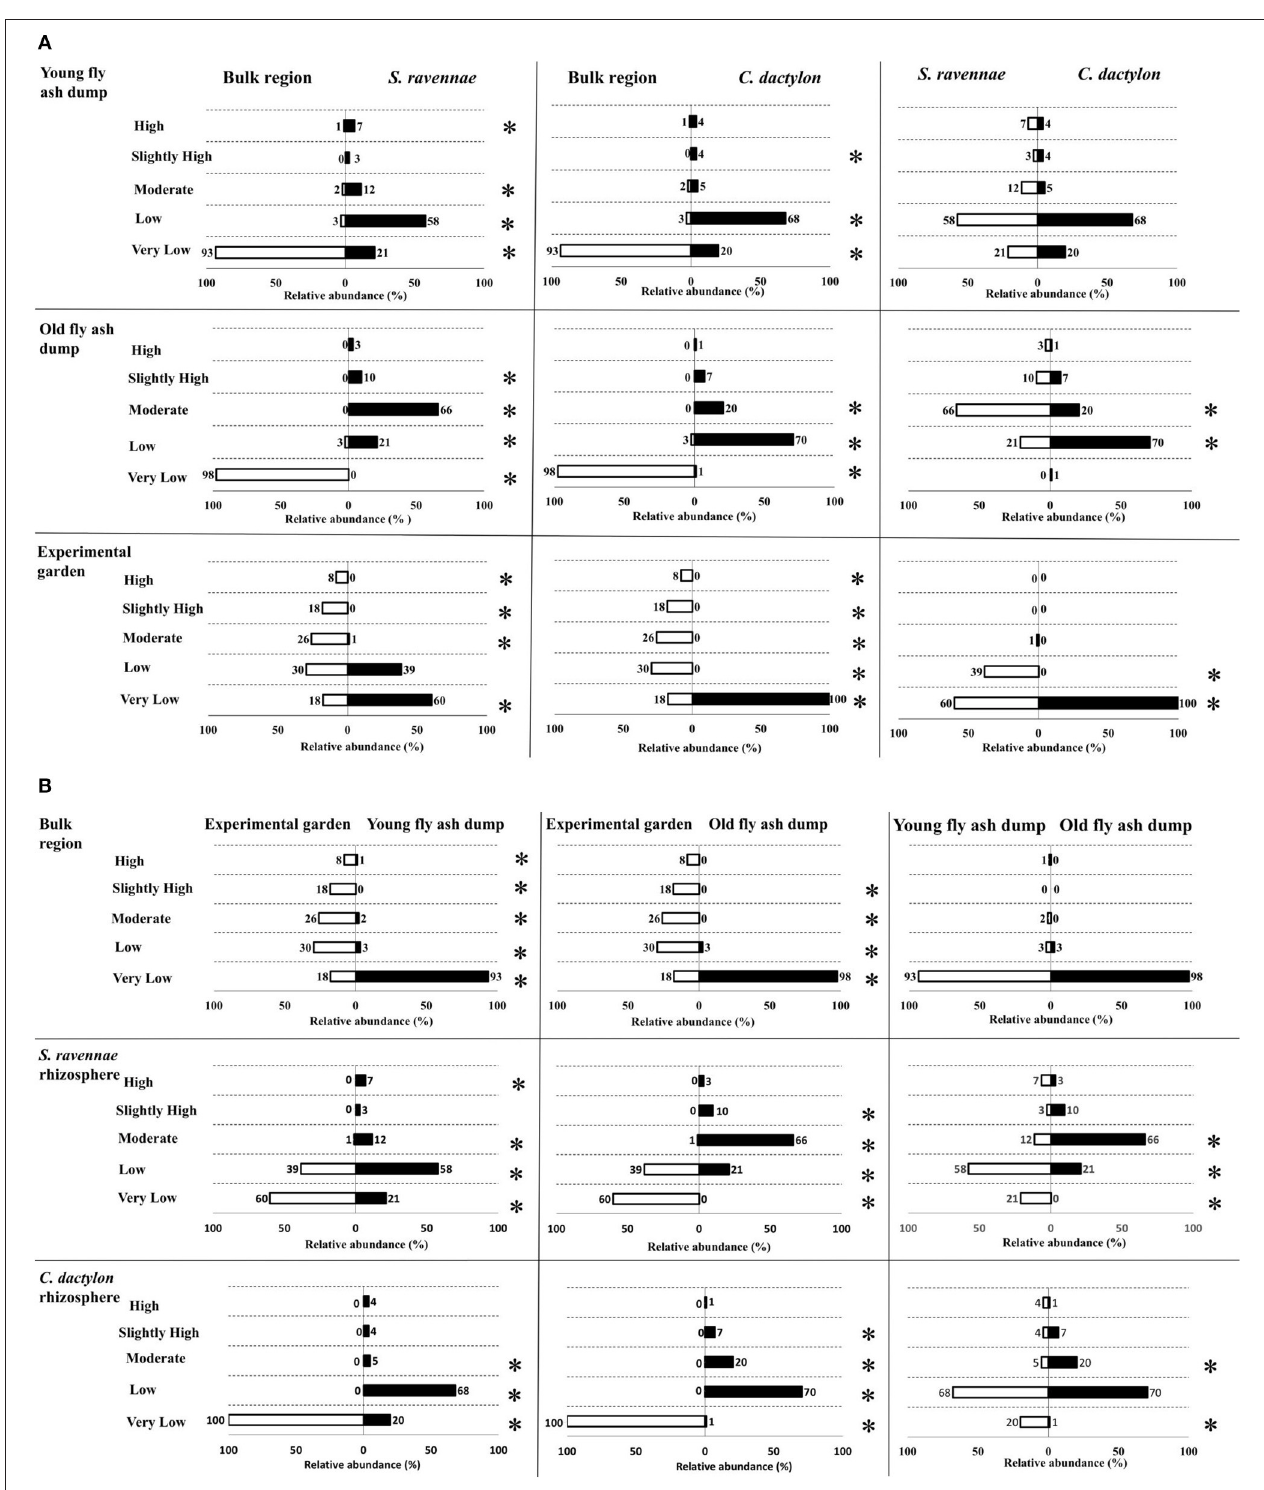
FIGURE 4 | Comparison of the relative abundance of IAA functional types from bacterial communities from non-rhizosphere (bulk) and rhizosphere ash/soil samples of S. ravennae and C. dactylon (A) , and different habitats, i.e., fly ash dumps of different age and experimental garden (B) . Numbers above the horizontal bars represent the proportion of isolates belonging to each functional type; “*” given on right side of the chart denotes the significant difference ( Z -test, p < 0.05) between the relative abundance of IAA functional types.